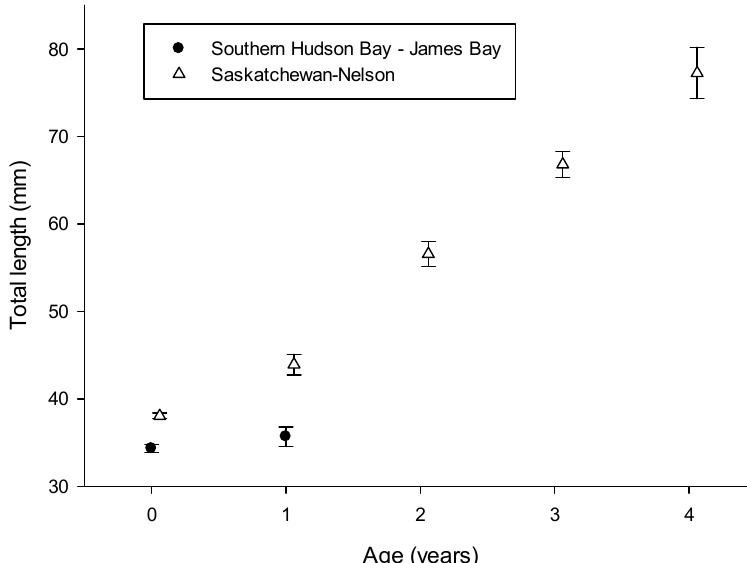
Figure 4. Mean length-at-age for River Darters sampled from two ecoregions, Southern Hudson Bay-James Bay and Saskatchewan-Nelson River, in the fall seasons of 2013–2014. Error bars represent ± standard error.